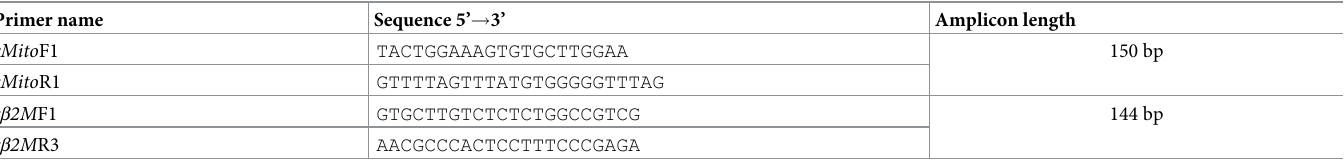
Table 1. Oligonucleotide sequences for mtDNA & nDNA determination using real-time qPCR. Primer